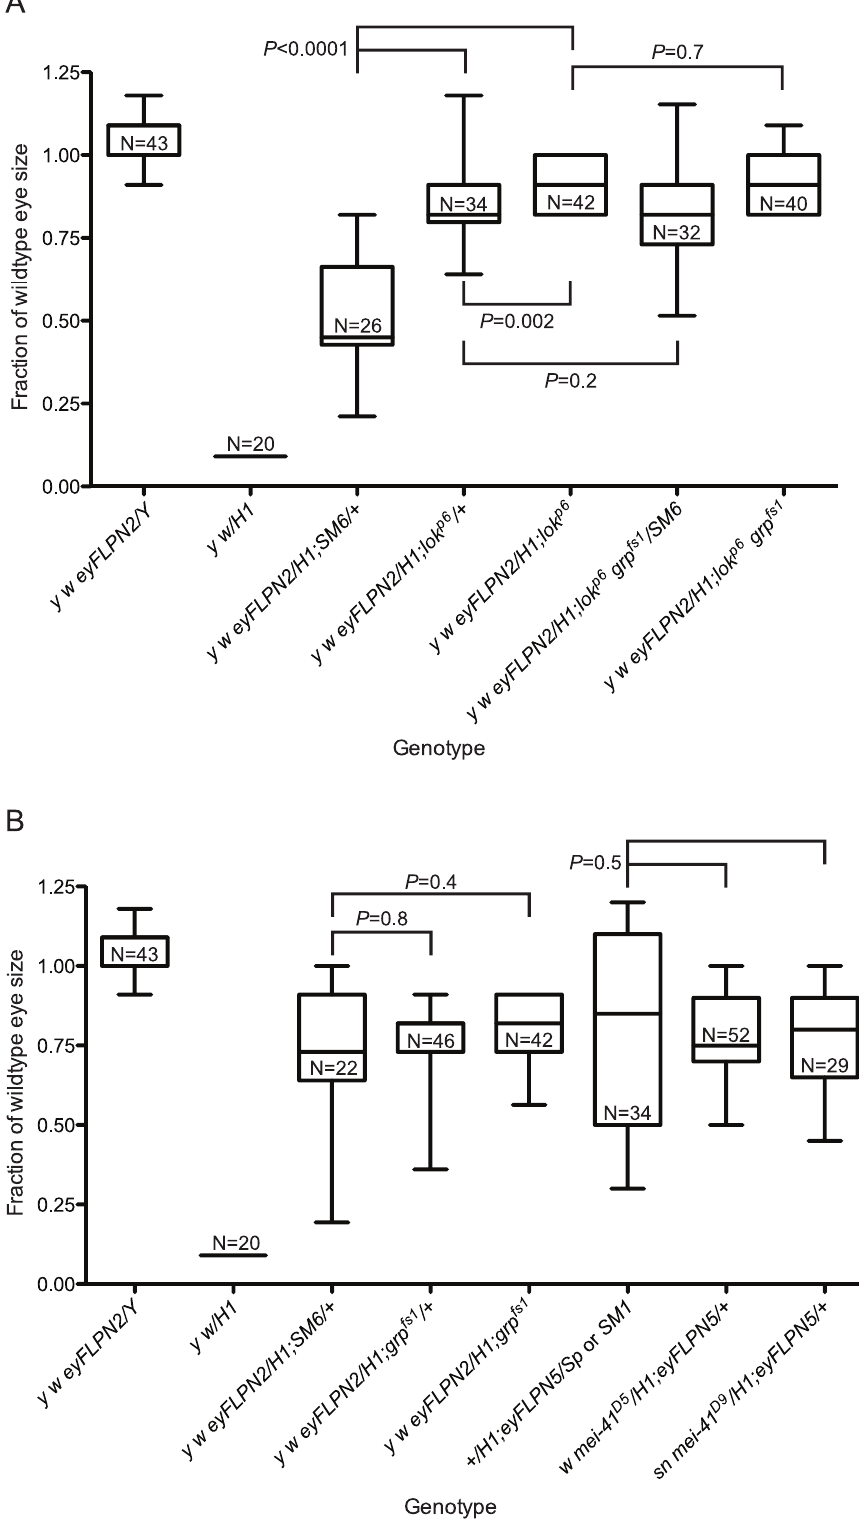
Figure 3. The role of DNA damage checkpoint proteins in the elimination of cells that have lost a telomere. All sizes are presented after normalization to wild type. Significance levels for critical comparisons are indicated. The first two whisker plots in each graph are controls and are repeated here (from Figure 2) for ease of comparison. (A) The effects of lok mutations. (B) The effects of grp or mei-41 mutations.